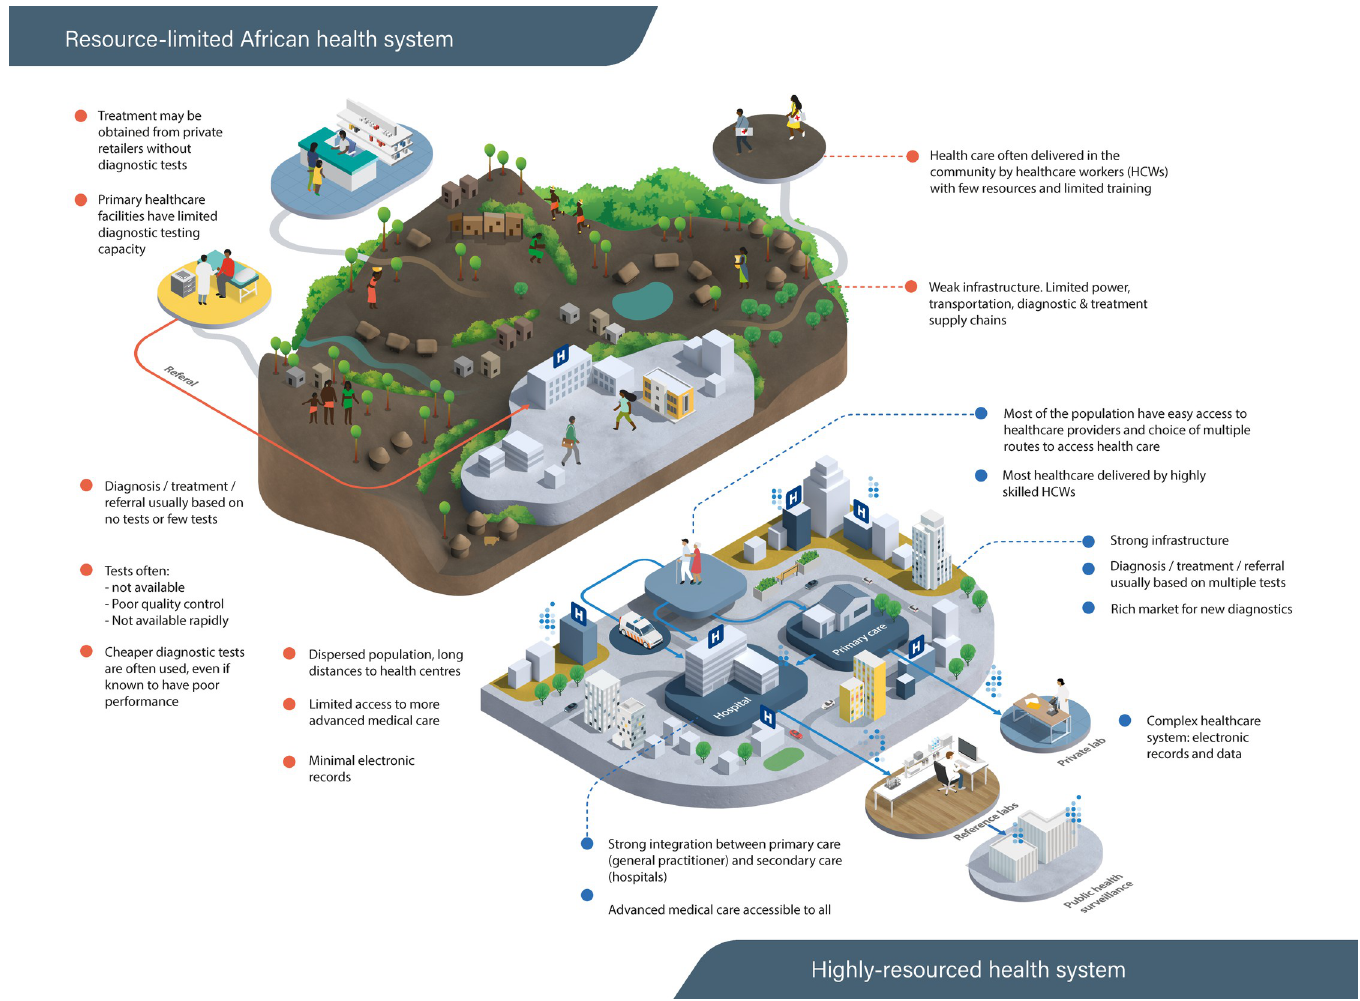
Fig 2. Contrasting access to healthcare and diagnostics between low-resourced SSA settings and highly resourced healthcare settings. In countries with highly resourced health systems, most of the population have easy access to health care services, often through multiple different routes. A wide range of diagnostic tests can be accessed through most healthcare providers, even if the samples need to be sent elsewhere for analysis. Strong infrastructure allows rapid transport, testing, and feedback of results, and diagnostic information can be shared between providers and patients with relative ease. Healthcare providers are often highly skilled and able to interpret the results of many different tests. In contrast, access to healthcare facilities and skilled healthcare workers in SSA is more heterogeneous and often limited, sometimes involving long journeys or incurring high costs to patients and their families. In rural and remote areas, the only accessible healthcare may be delivered by less skilled community healthcare workers, equipped with a limited range of point-of-care diagnostic tests. Healthcare facilities with high-quality laboratories do exist, but their capacity and the infrastructure to transport samples from distant facilities to these laboratories and return results in a timely fashion is often insufficient for the needs of the population, and results in further gaps in their linkage to appropriate and timely patient care. SSA, sub-Saharan Africa.